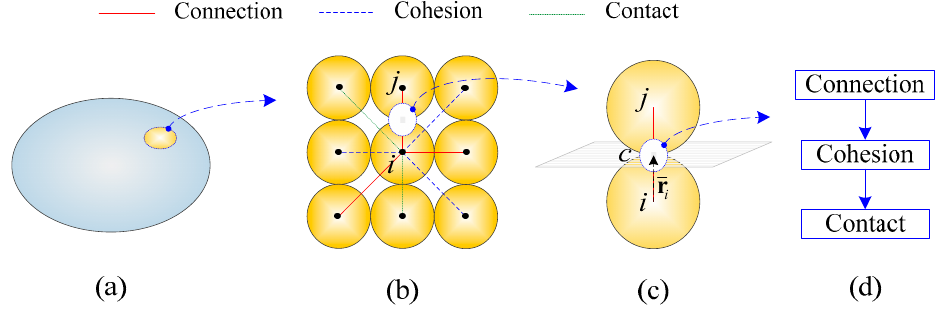
Figure 7. Model transition from a connective relation to cohesion and further to a contact relation: ( a ) an elastic solid represented by the discrete element connective model at microscale; ( b ) various relations among different particle pairs; ( c ) a representative particle pair; ( d ) monotonic model transition.